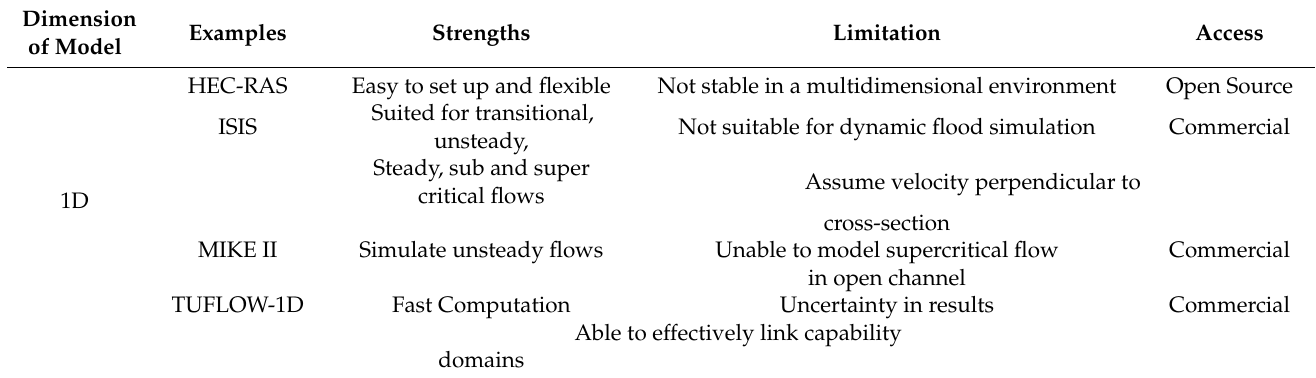
Table A1. Summary of the one-dimensional (1D) numerical tool in flood modelling.